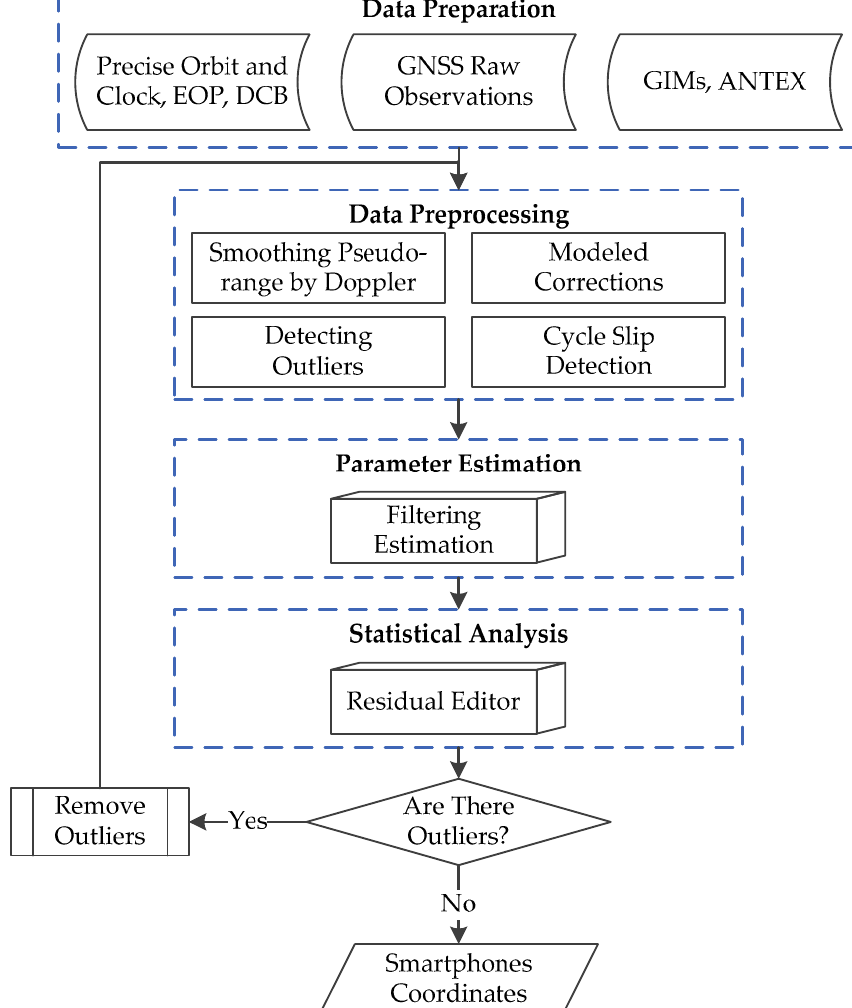
Figure 3. Flowchart of ionosphere-constrained single-frequency PPP processing for the smartphones.